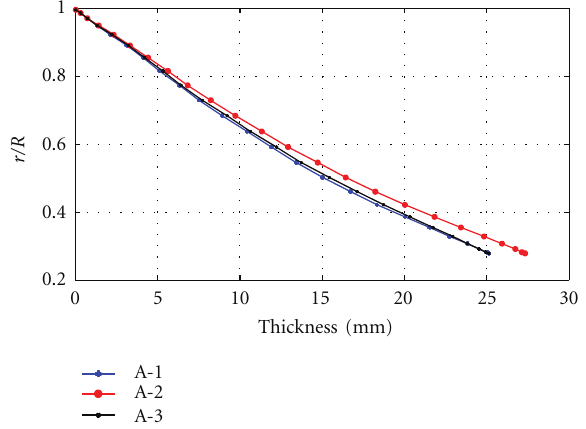
Figure 16: Thickness distribution, aft propeller.